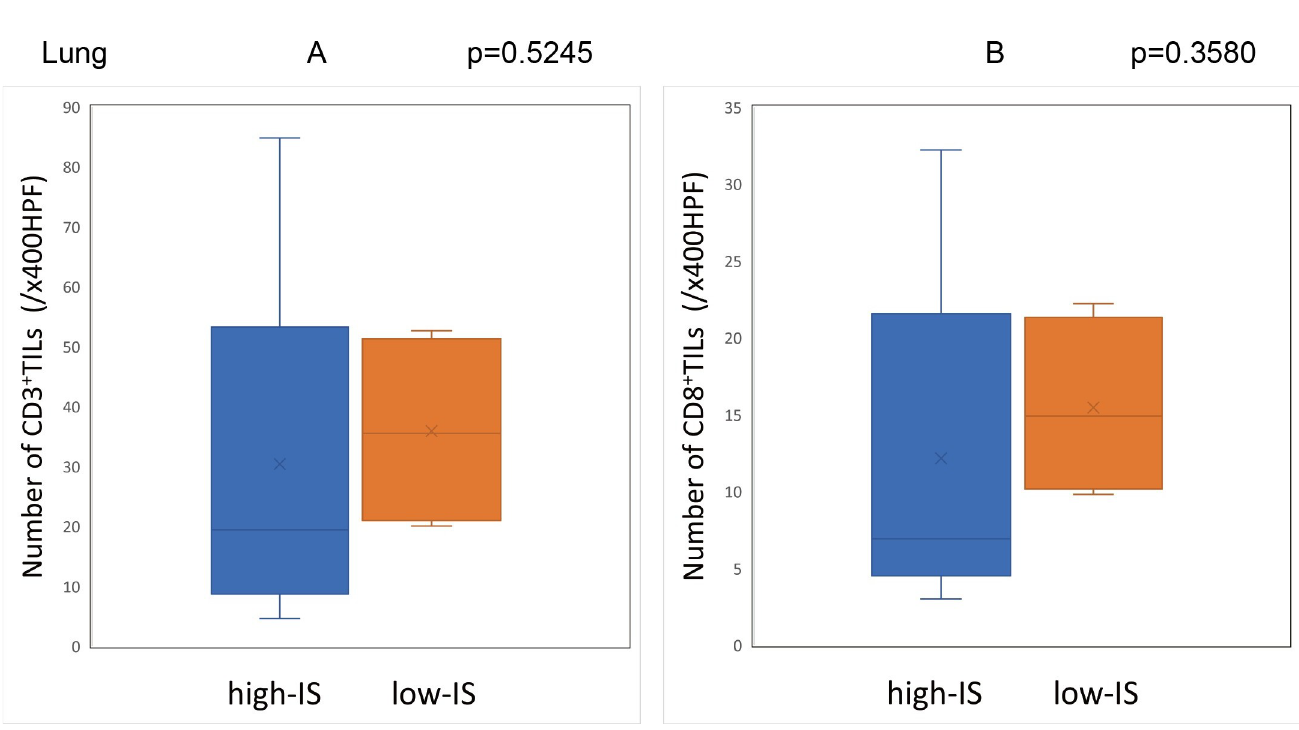
Fig 11. Relationship between the Immunoscore of primary tumors and the degree of TIL infiltration in the lung metastases. (A) (B) There was no significant difference between the Immunoscore of primary tumors and the density of tumor-infiltrating lymphocytes in lung metastases. https://doi.org/10.1371/journal.pone.0255049.g011 PLOS ONE | https://doi.org/10.1371/journal.pone.0255049 July 22,